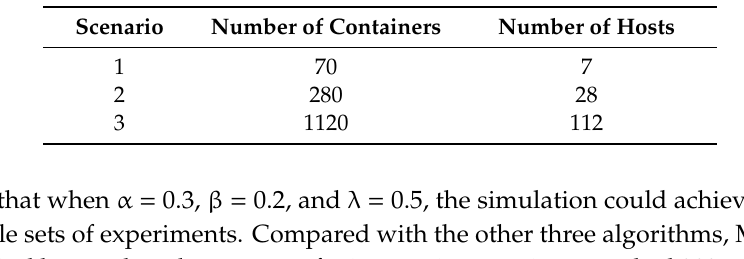
Figure 7. The flow of Container-CloudSim simulation.